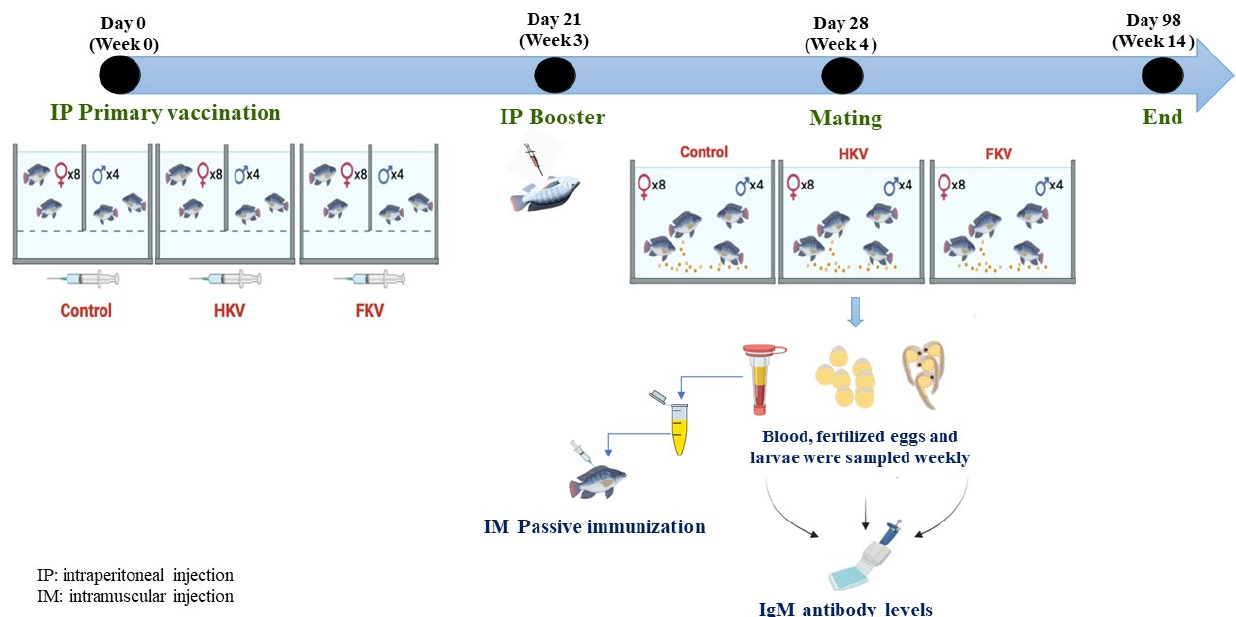
Figure 1. Diagram illustrating the experimental design for broodstock TiLV vaccination, mating and sampling.